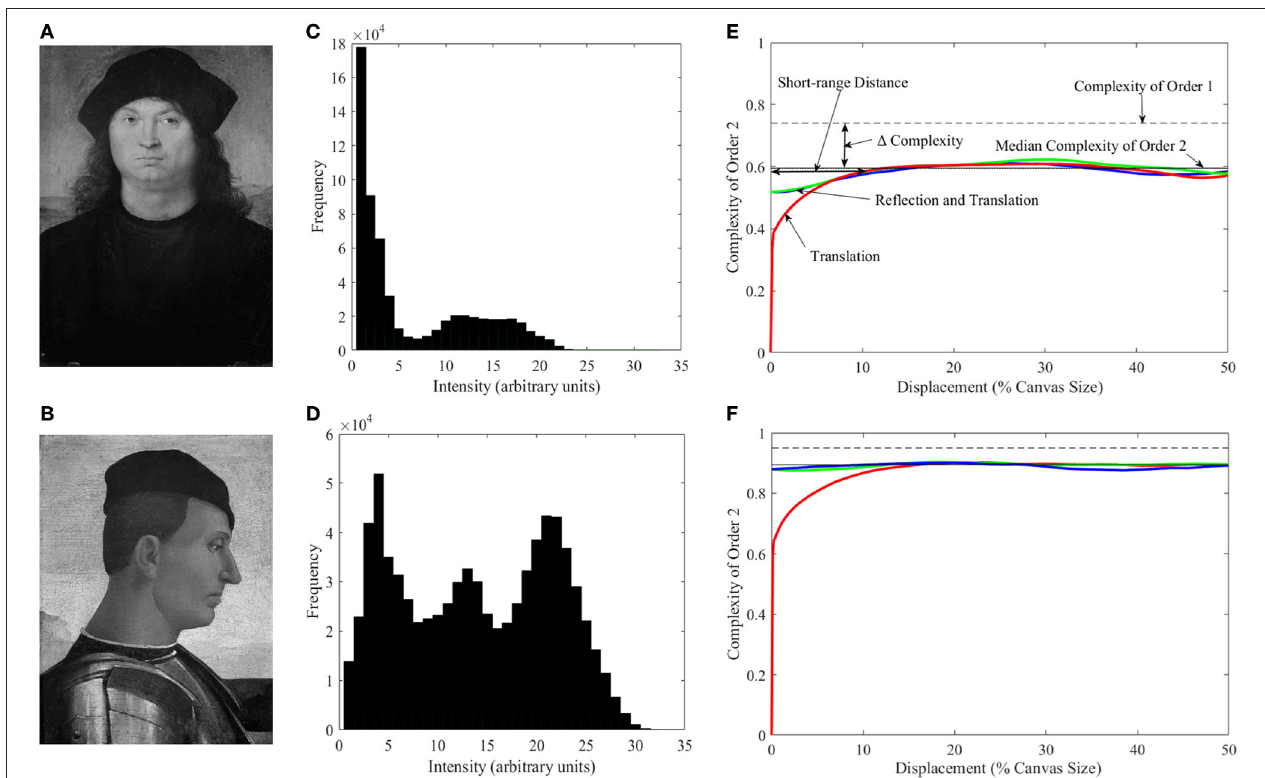
FIGURE 1 | Illustration of different types of complexity. (A) Portrait of a Man by Pietro Perugino 1 (Galleria Borghese, Rome, Italy; Photo © 2006, Scala, Florence, Italy; reproduced by courtesy of the Ministero Beni e Att. Culturali, Rome, Italy). (B) Camillo Vitelli by Luca Signorelli (Berenson Collection, Villa I Tatti, Florence, Italy, reproduced by permission of © President and Fellows of Harvard College). (C,D) Histograms of the intensities in A and B respectively. (E,F) Plots of complexity as a function of the amount of translation (as percentage of the canvas size) in different isometric transformations for the Perugino and Signorelli paintings respectively. Complexity of Order 1 is marked with the dashed line. Complexities of Order 2 for left and right translations are represented by the red line (both directions give identical results). Blue and green lines present the linear combinations of horizontal reflection and translation to the left and right respectively. The solid line shows the median of Complexities of Order 2 across all possible transformations. The figure also illustrates the Short-range Distance, i.e., the range of distances for which Complexity of Order 2 varies with displacement. We define this distance as the threshold at which the red line crosses the median Complexity of Order 2 minus its median absolute deviation. “ 1 Complexity” is defined as the difference between Complexity of Order 1 and the median Complexity of Order 2 within the Short-range Distance. We call this latter quantity the Short-range Complexity. The figure shows that the Perugino painting has lower Complexities of Order 1 and Order 2, and larger 1 Complexity than the Signorelli piece (see text for more